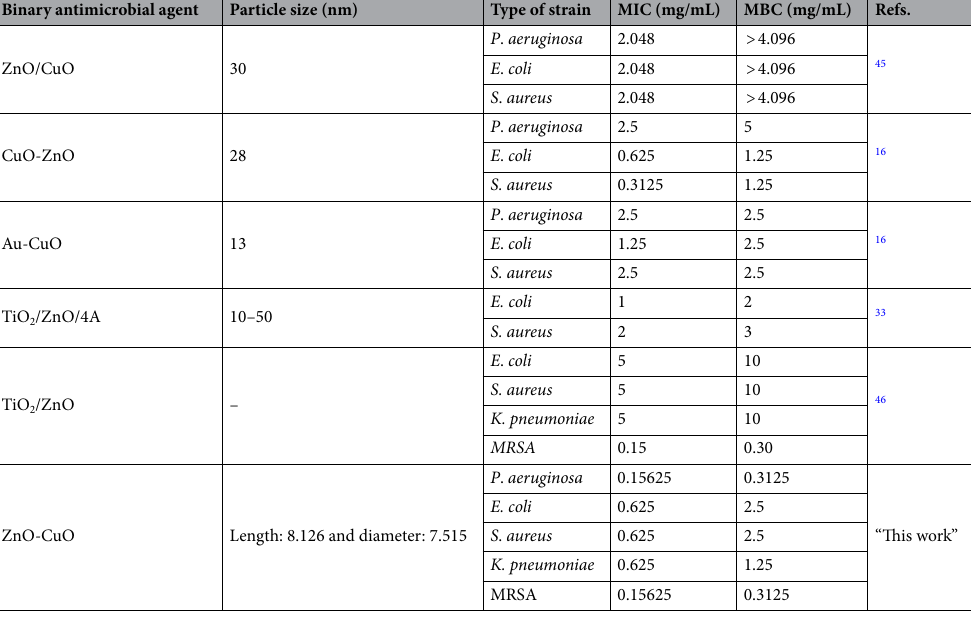
Table 2. MIC and MBC concentration of binary antimicrobial agent.